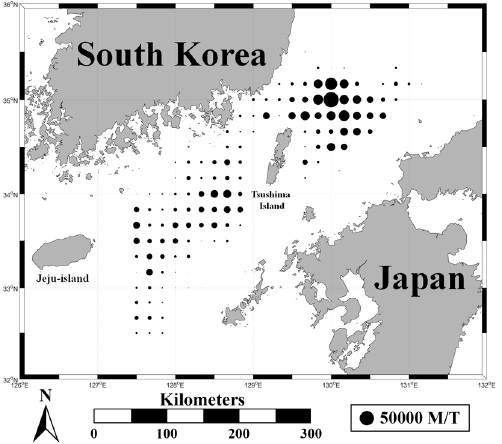
Figure 1. Summarized commercial catch data for the chub mackerel from 2010 to 2016.